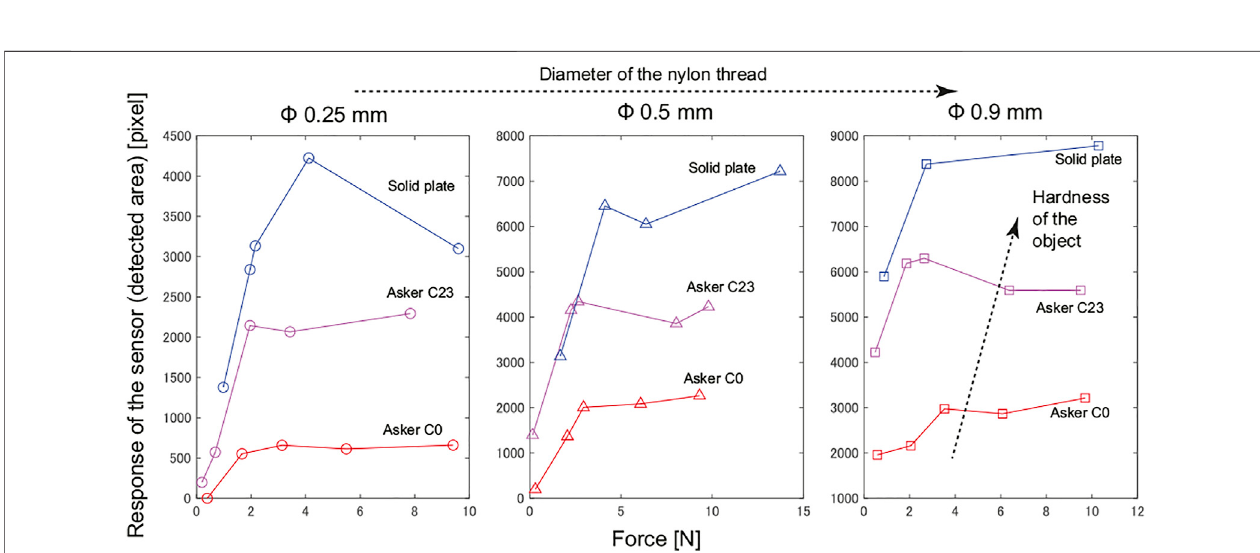
FIGURE 9 | Experimental results of hard object piece detection: Relationship between sensor response (detected area) and pushing force in various conditions.